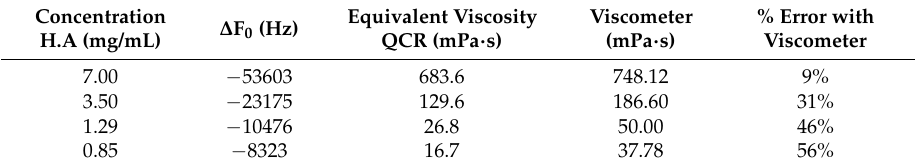
Table 6. ∆ F 0 and equivalent viscosity related only to the viscous component of hyaluronic acid mixtures. Concentration H.A (mg/mL)